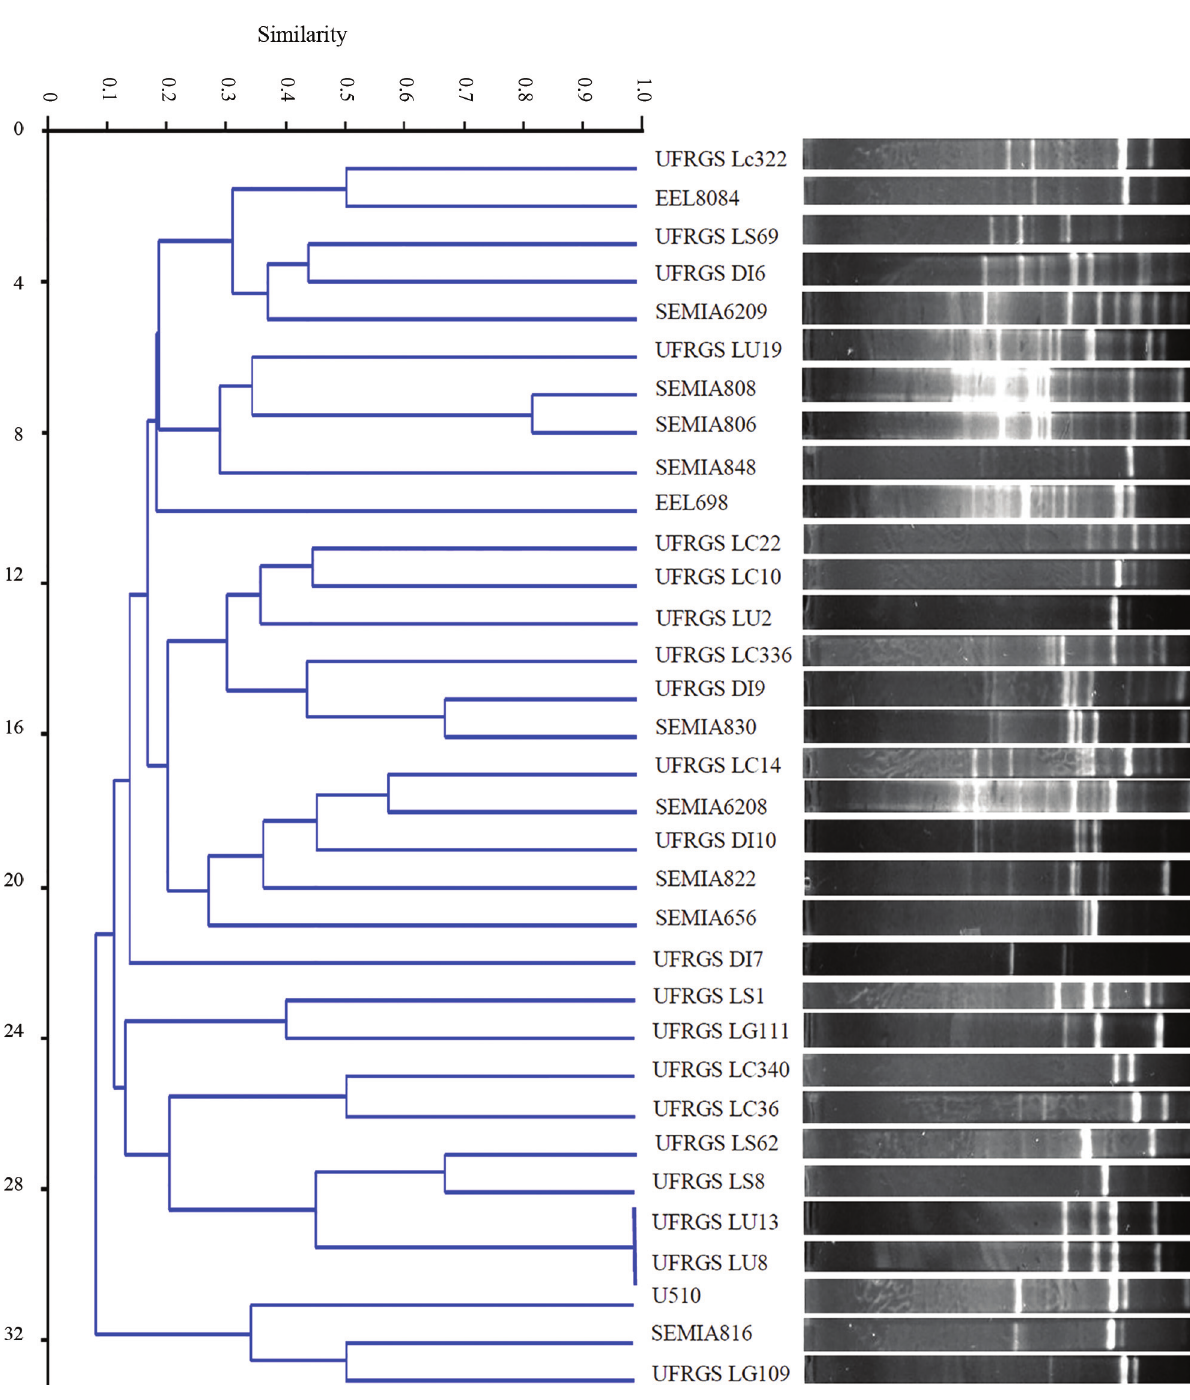
Figure 1 - Dendrogram of genetic similarity based on UPGMA cluster analysis using the Jaccard coefficient (PAST software). Data were obtained through BOX-PCR analysis of 21 rhizobia isolated from the root nodules of D. incanum , L. corniculatus , L. subbiflorus , L. uliginosus , L. glaber and 12 rhizobia reference